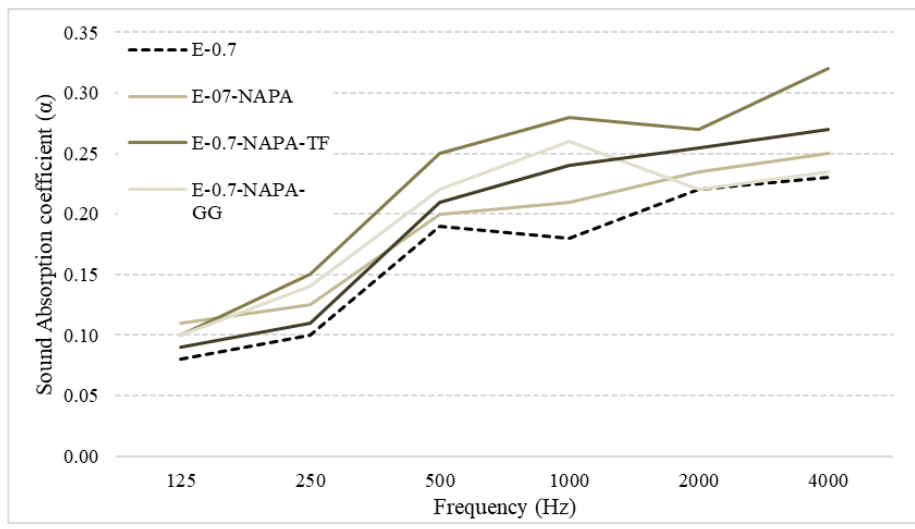
Figure 21. Sound absorption Coefficient (α) test results.